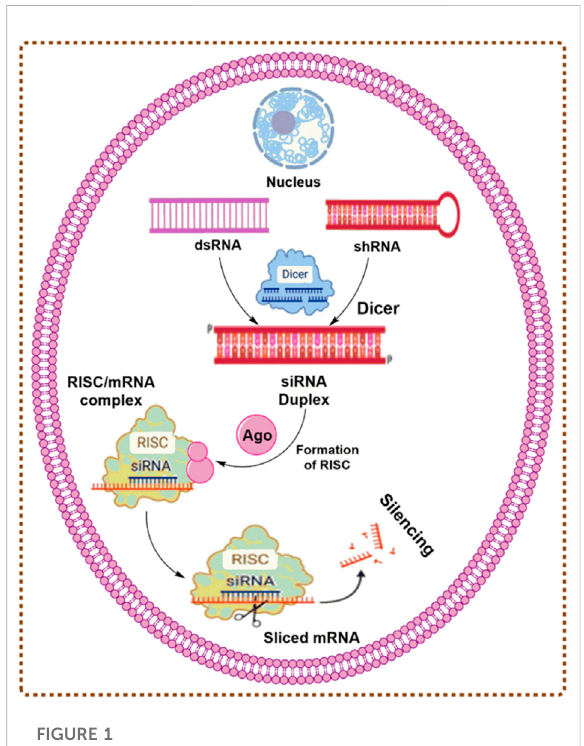
FIGURE 1 The mechanism of gene silencing by